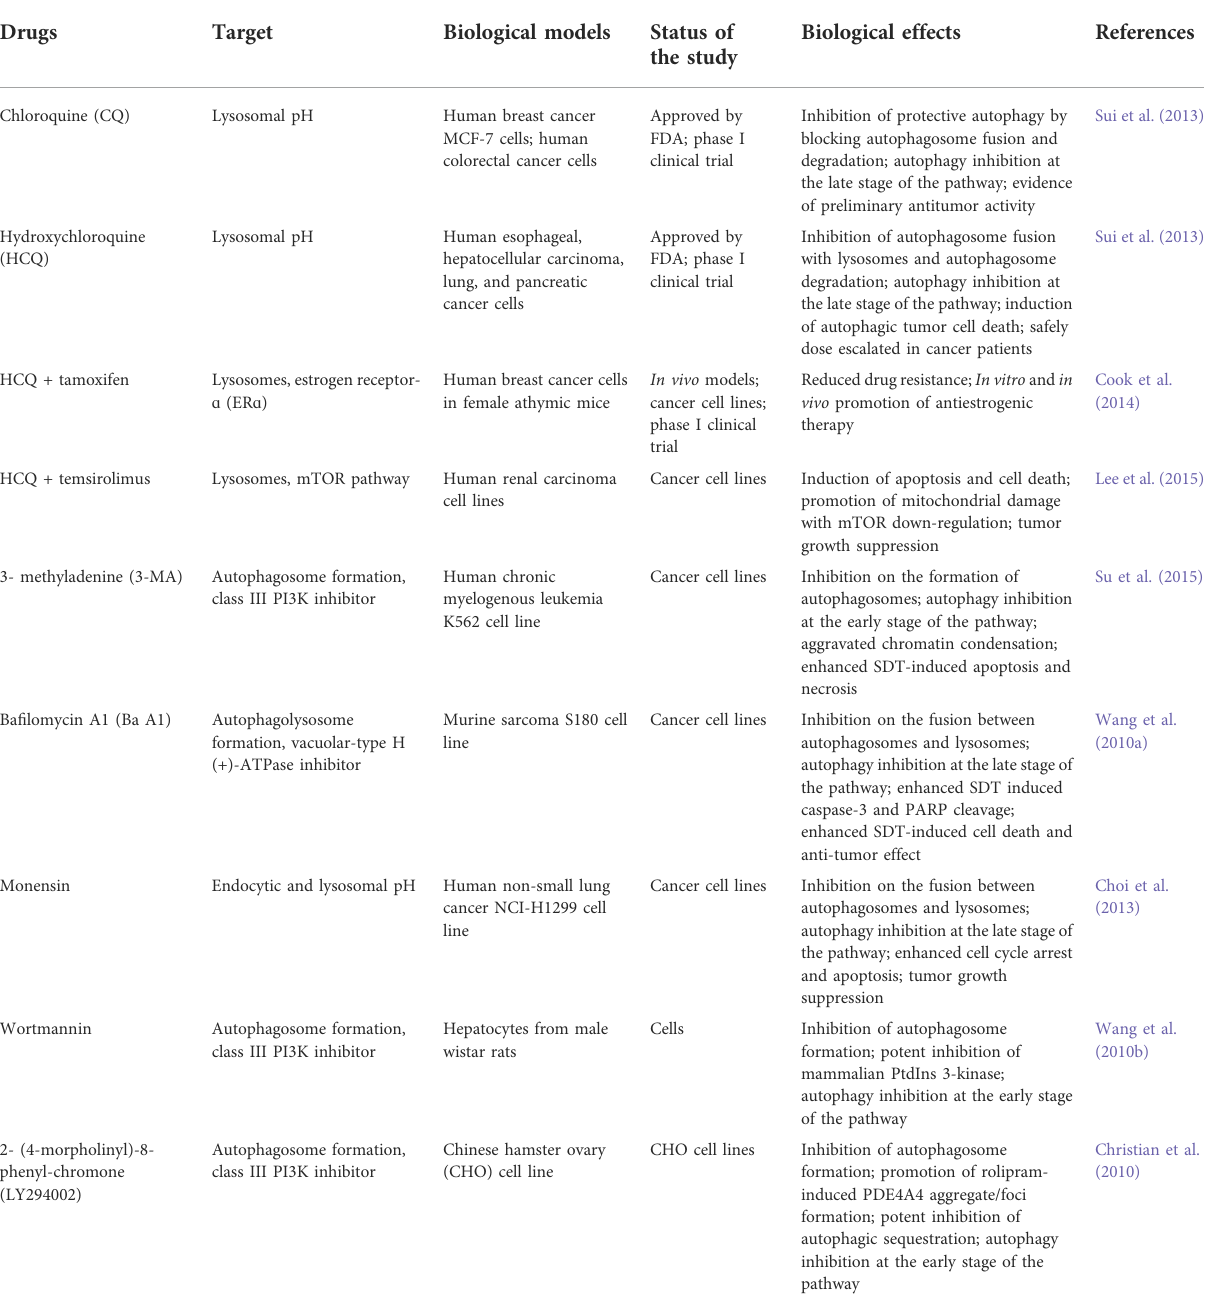
TABLE 5 Summary of autophagy